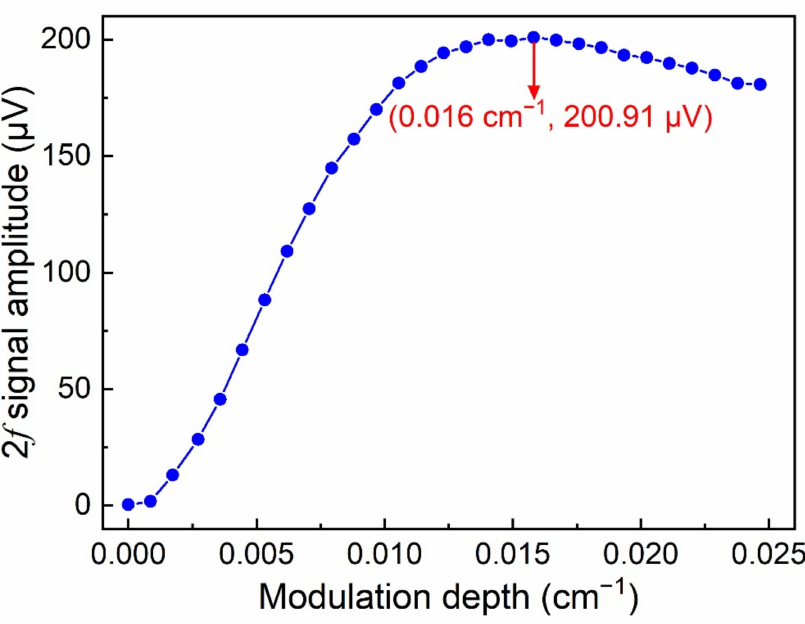
Figure 4. The relationship between the 2 f signal amplitude and the modulation depth when H 2 concentration was 100% for the H 2 -TDLAS sensing